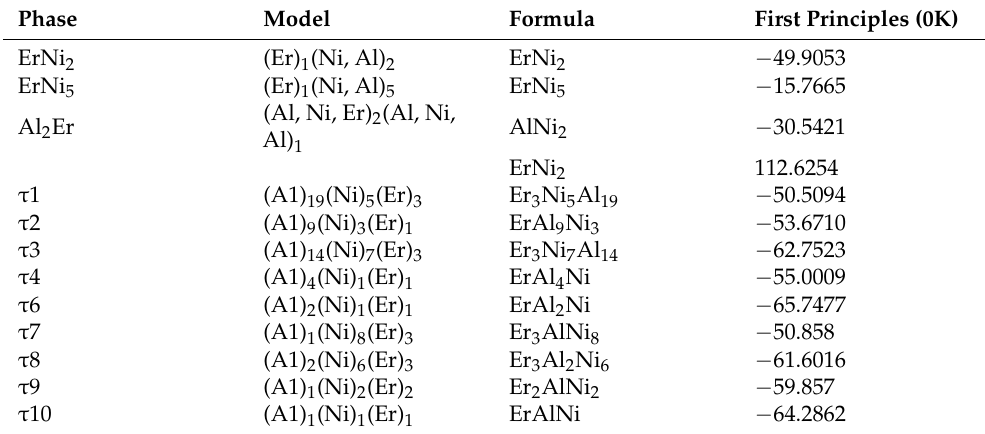
Table 5. Formation enthalpy from first-principles calculations kJ/(mole of atoms).